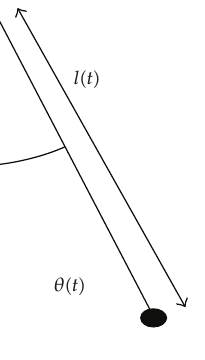
θ (cid:4) t (cid:5)